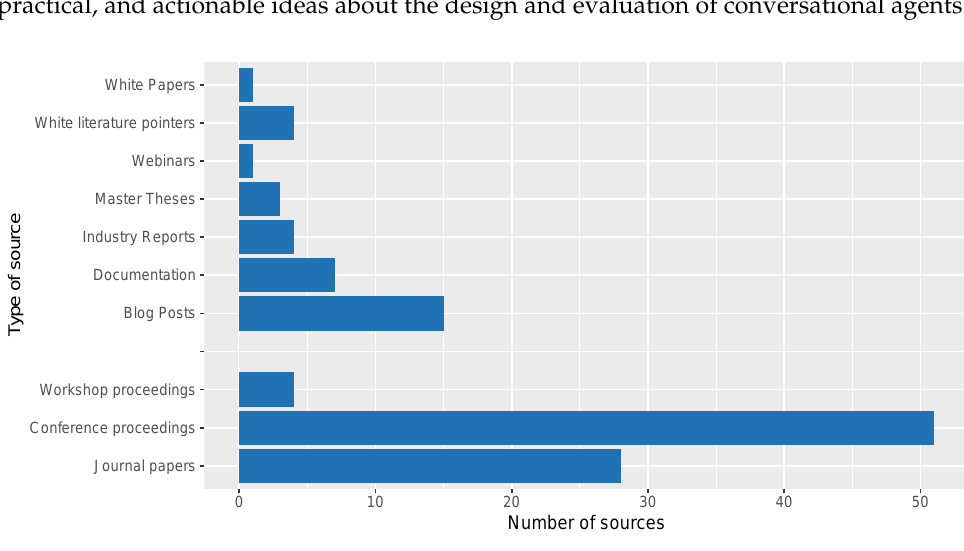
Figure 3. Types of grey and white literature